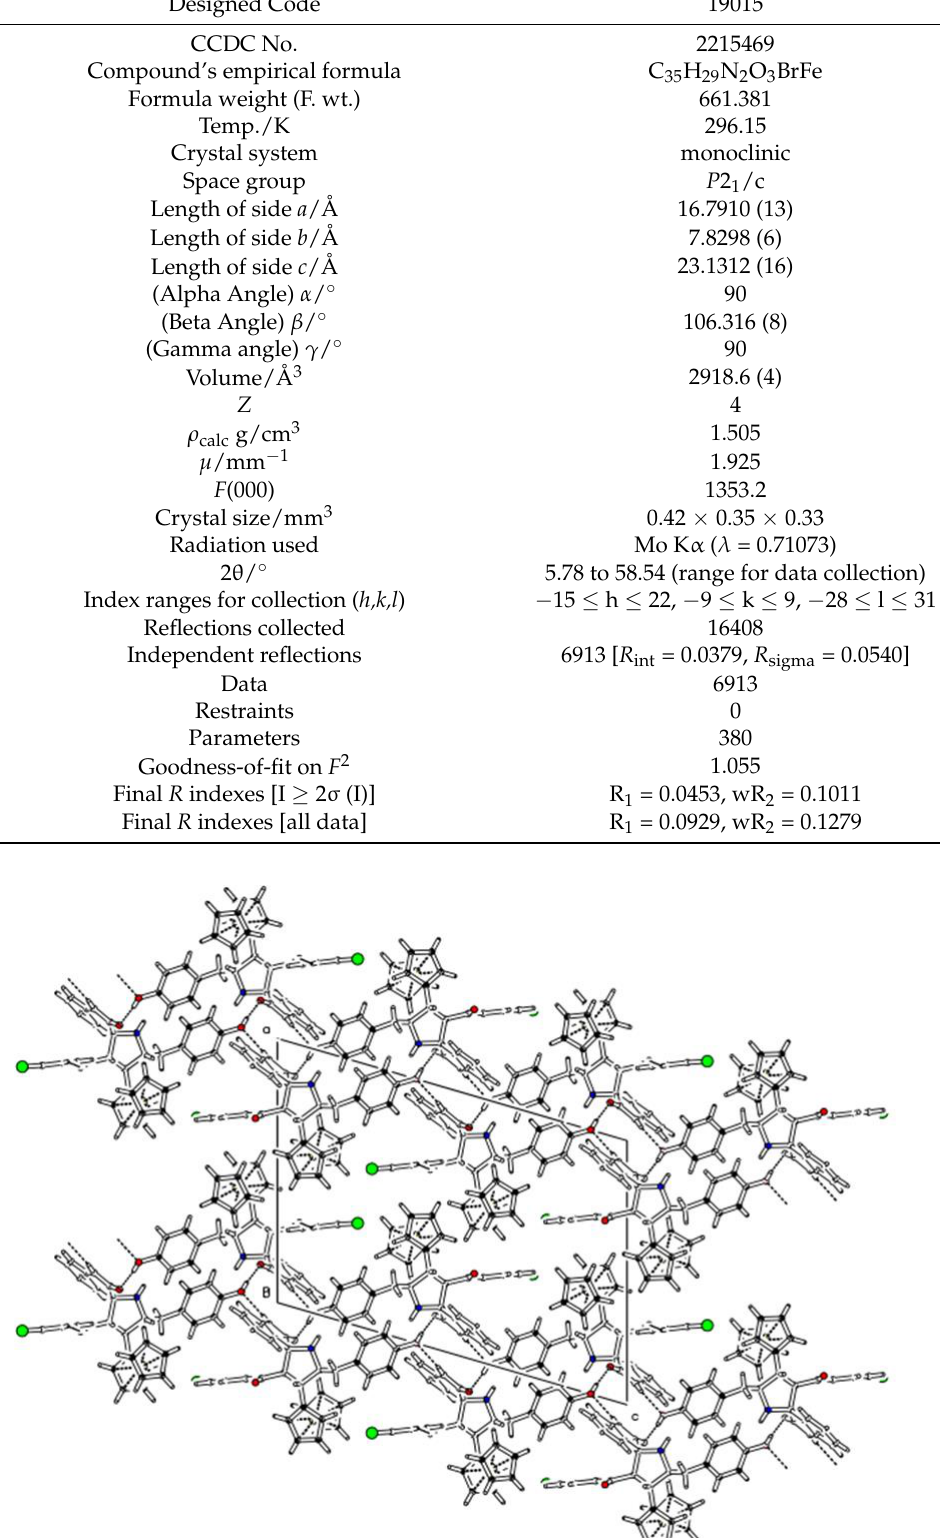
Figure 2. A view along the ac -plane showing different hydrogen bonding interactions. Table 5. Structural unique crystal data and refinement parameters for 3a.